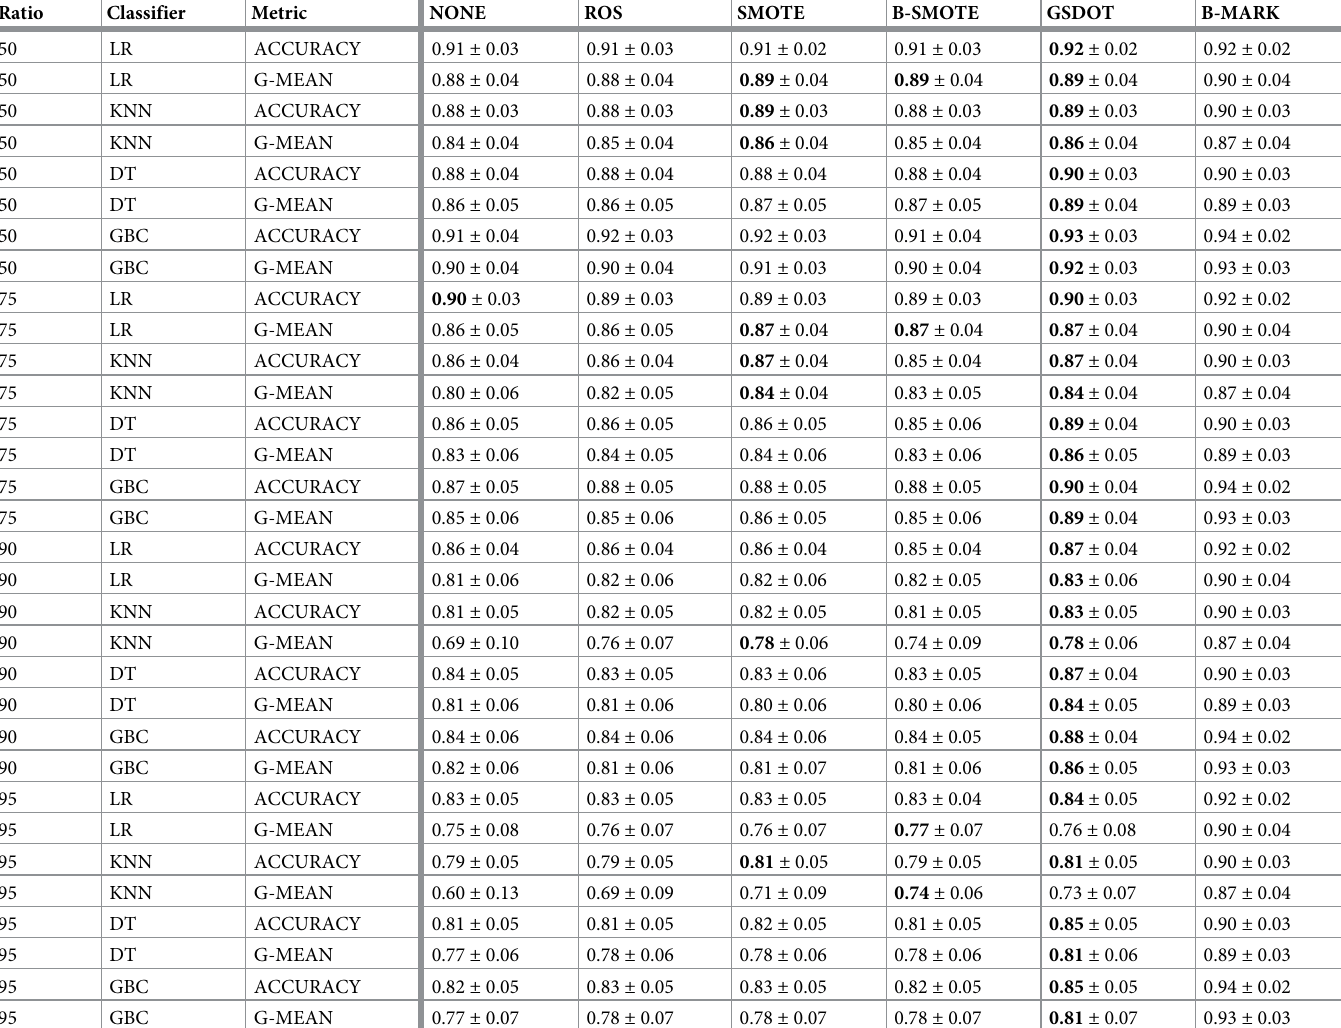
Table 2. Results for mean cross validation scores of all